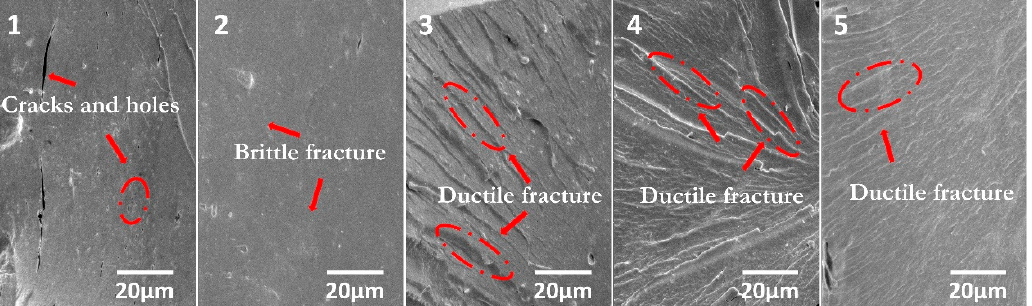
Figure 7. SEM images of fracture surfaces of cured adhesives: 1: SPI adhesives, 2: SPI/PAE adhesives, 3: SPI/PAE/0.2% FGO adhesives, 4: SPI/PAE/0.4% FGO adhesives, and 5: SPI/PAE/0.6% FGO adhesives.